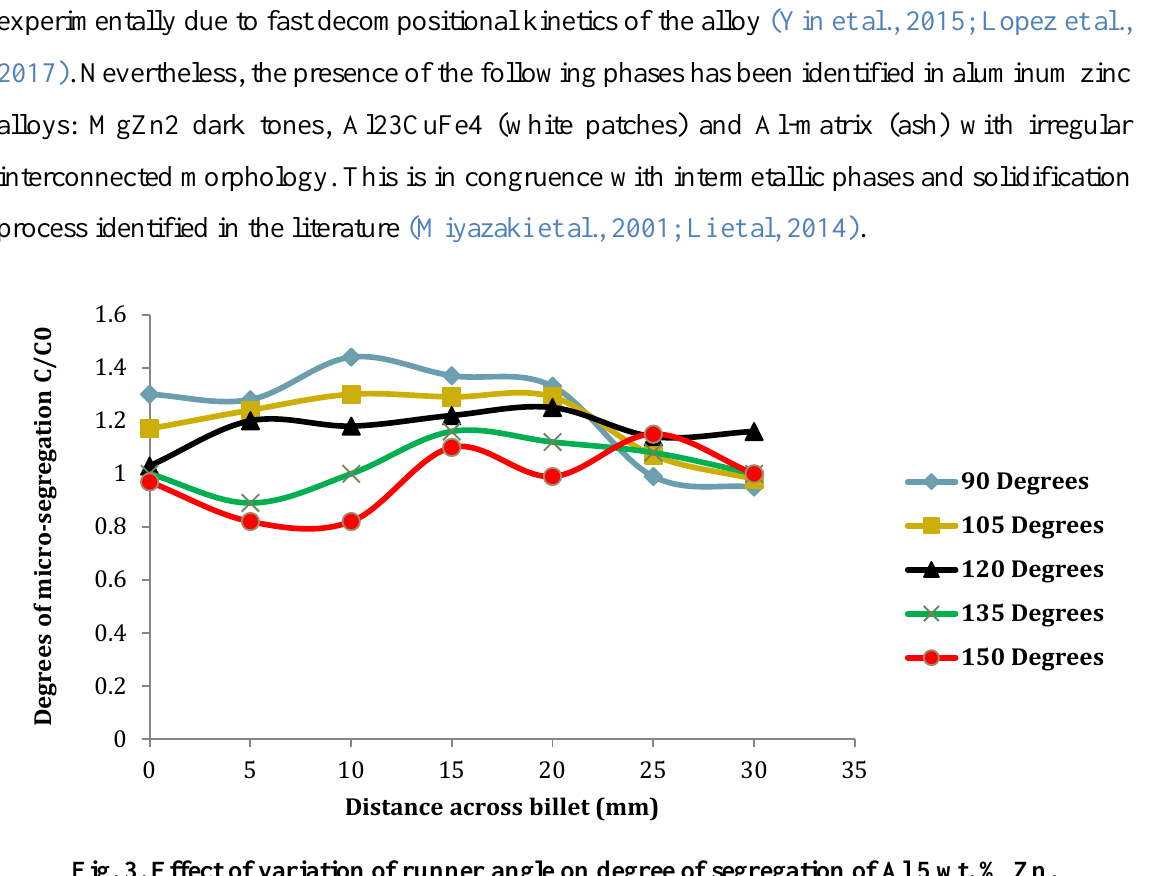
Fig. 3. Effect of variation of runner angle on degree of segregation of Al 5 wt. % Zn.